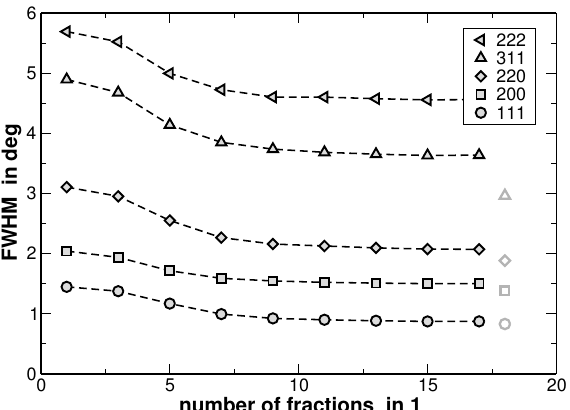
Figure 8. FWHM values of the underlying Gaussian profiles fitted to the labeled reflections of the AuCuNiPt alloy in a highly segregated state in dependence of the number of fractions used for fitting. In addition, the FWHM values obtained from the homogenized state and fitted with a single Gaussian profile are shown (grey symbols).